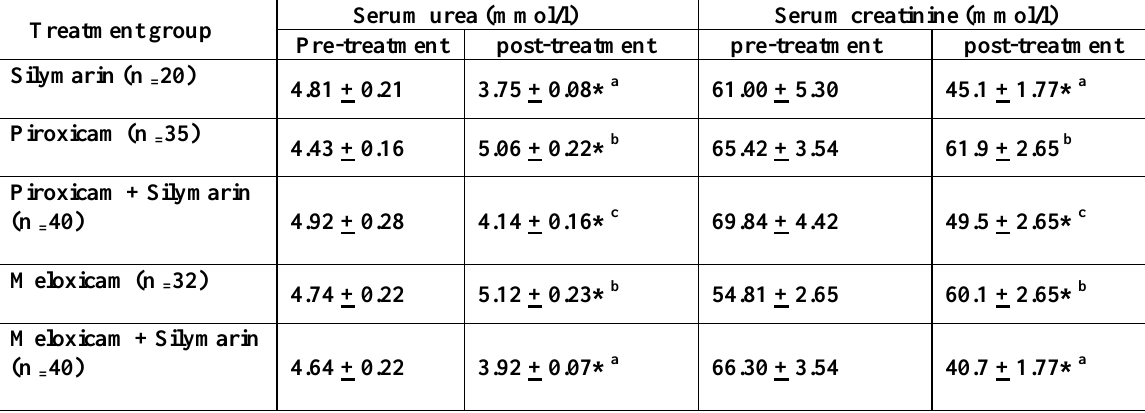
Table 1. Effects of silymarin on the serum levels of urea and creatinine in OA patients treated with piroxicam or meloxicam.